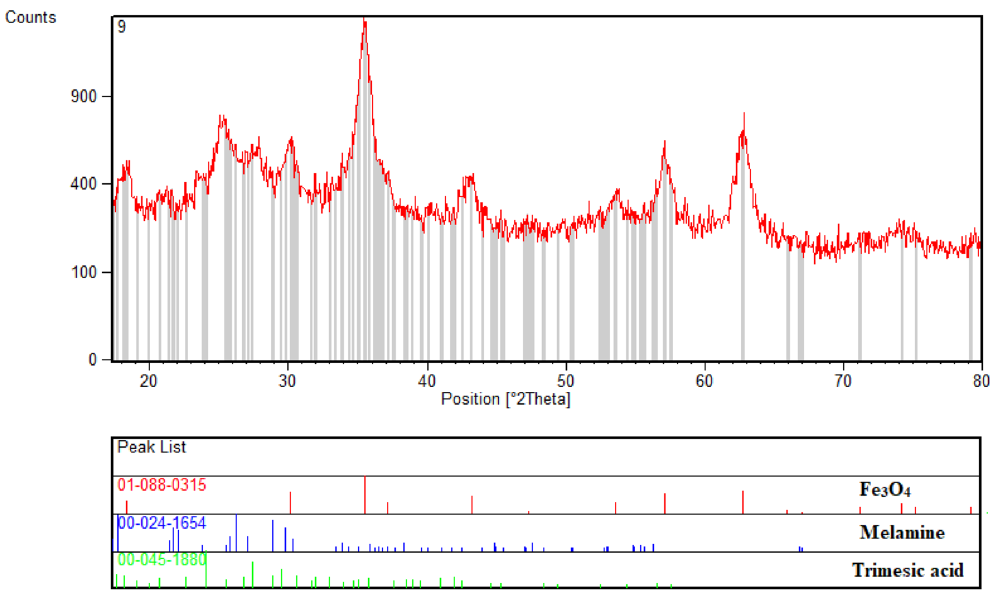
Figure 7. XRD pattern of the Fe 3 O 4 /SiO 2 -TMA-Me nanocomposite ( 1